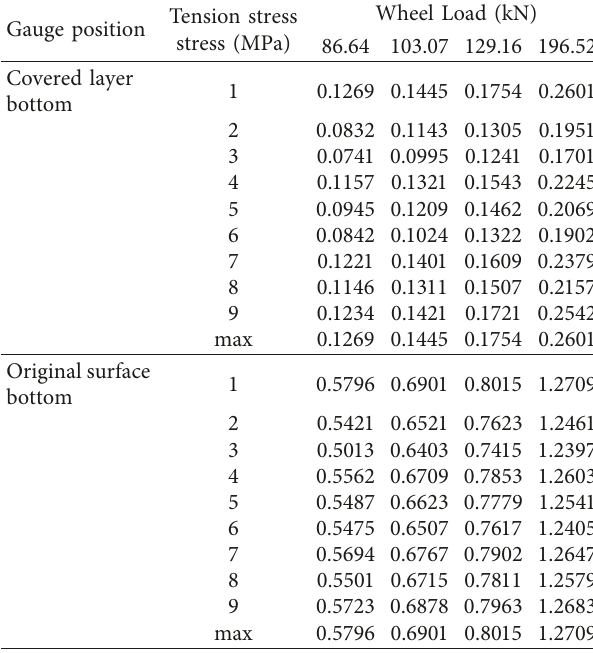
Table 4: The tension stress at the slab bottom.